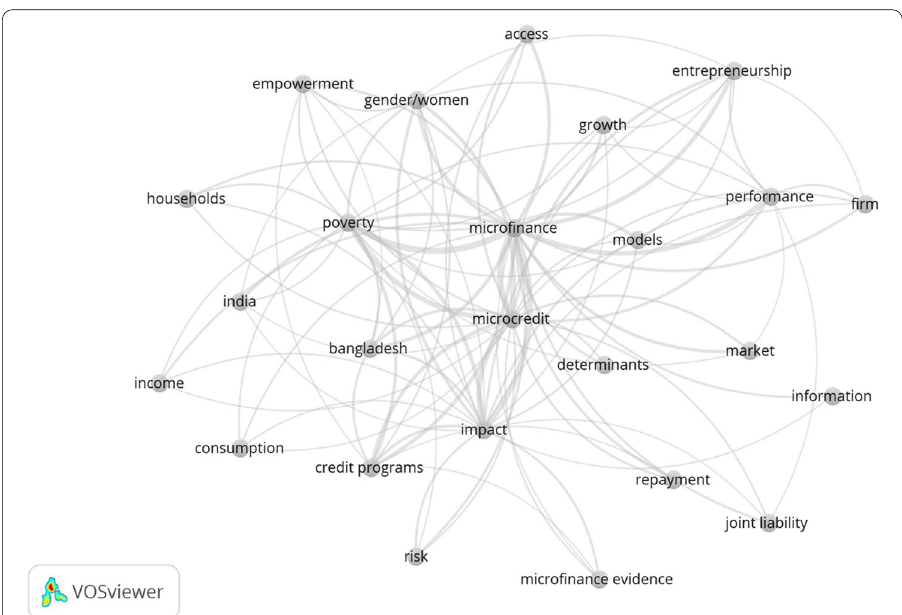
Fig. 4 Network of keyword occurrences in the 524 articles selected from the study sample, covering the period between1:2012 and 03:2021 according to the fractional counting